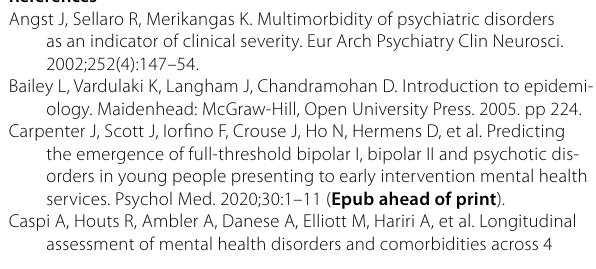
Additional file 3: Appendix 3 : Figure S1 . Trajectory paths for FH and non-FH. Figure S2 . Trajectory plots for Probands and